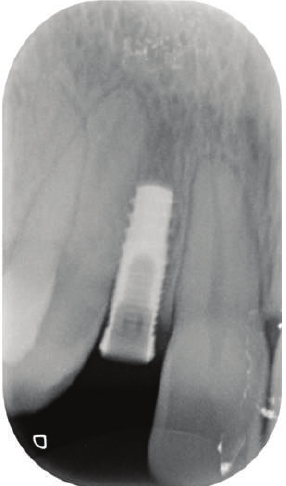
Figure 12: Radiographic control after implant placement in site to the left.